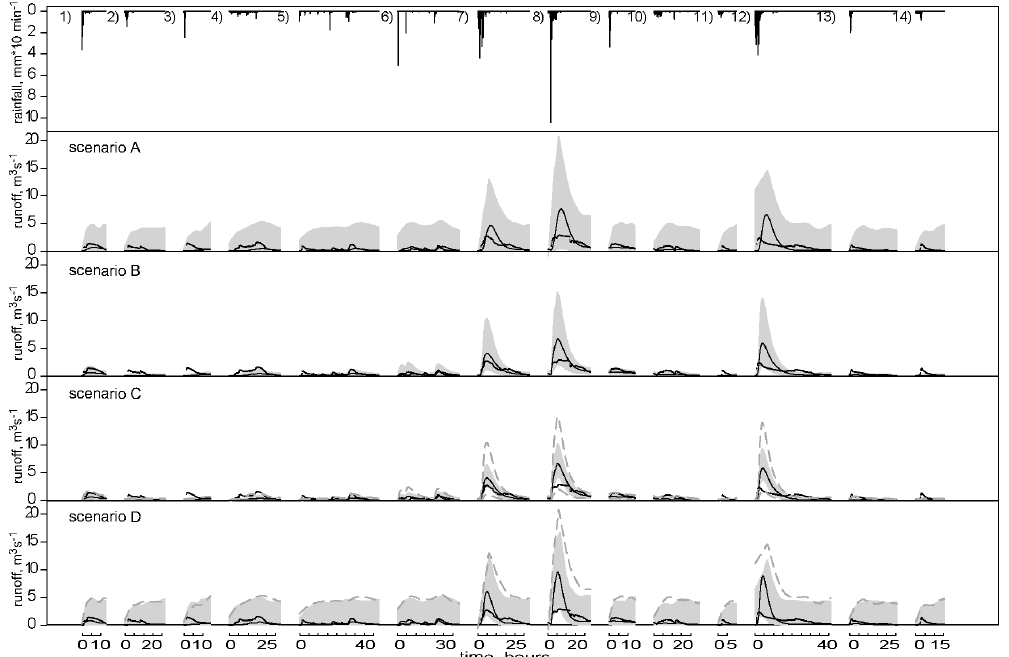
Fig. 5. Predicted flows in the Sluzew Creek using the prior and posterior parameter distributions for different scenarios. Solid lines preset predicted runoff corresponding to the median parameters values, dotted lines – observations. Grey areas depict 80% prediction uncertainty bands. For scenarios C and D – dashed lines indicate the difference in the total predictive uncertainty bands whilst ignoring input error (scenario C) or parameters uncertainty (scenario D). Numbers in brackets correspond to the number of the event.